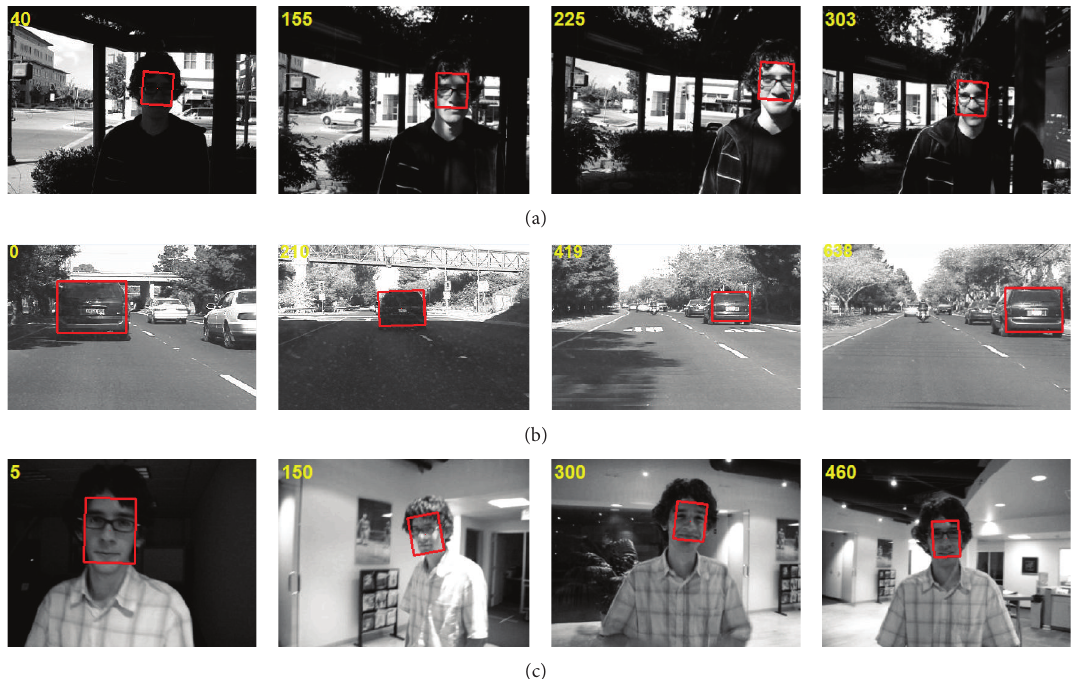
Figure 12: Tracking results for some sequences which had been tested in [7]. The first row: results for the sequence “trellis70.” The second row: results for the sequence “car4.” The last row: results for the sequence “davidin300.”